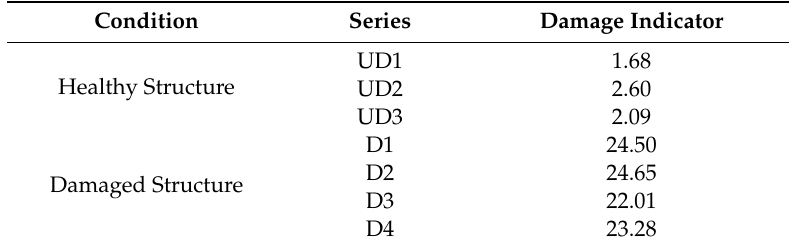
Table 1. Damage indicator values for all measurements in undamaged and damaged structures.